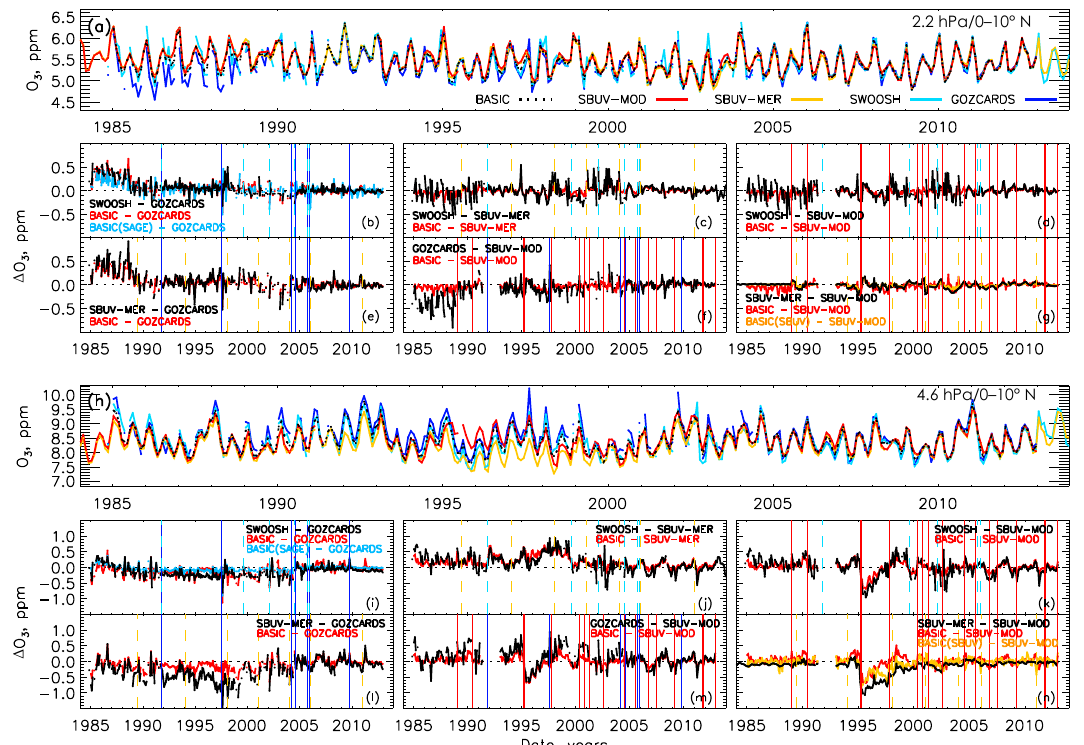
Figure 7. Ozone time series at two stratospheric locations from 1984 to 2014, all bias shifted to the mean of SWOOSH after June 2005. (a) Absolute ozone at 2.2hPa over 0–10 ◦ N from SWOOSH (light blue), GOZCARDS (blue), SBUV-MER (yellow), and SBUV-MOD (red). (b–g) The difference between each pairing of the four composites and with the BASIC composite (see legends). Panels (h–n) are the same as (a–g) but at 4.6hPa and 0–10 ◦ N. Solid and dashed vertical lines represent months with a change in the instrument used to construct the composite (colours are with respect to the composite colour in panels a and h